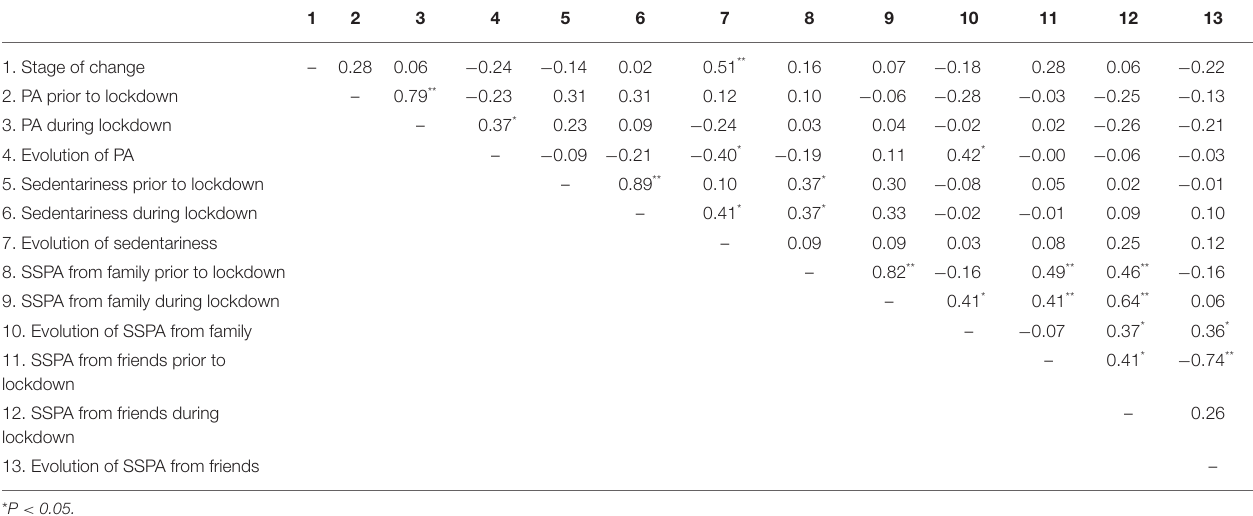
TABLE 5 | Bivariate Correlations for Retirees ( n = 39).